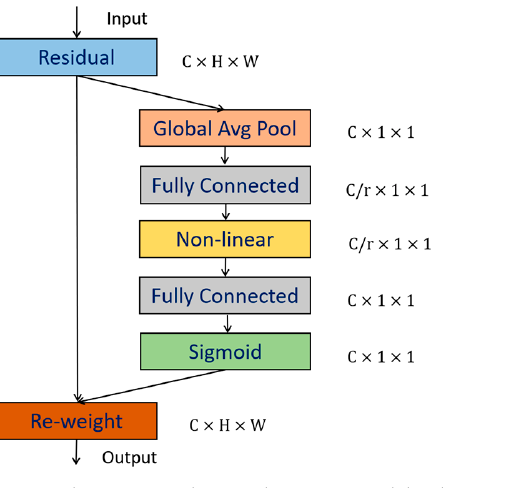
Figure 3. The details of the position-enhanced attention block ( C, W, H, r represent the number of channels, width, height and reduction ratio, respectively).